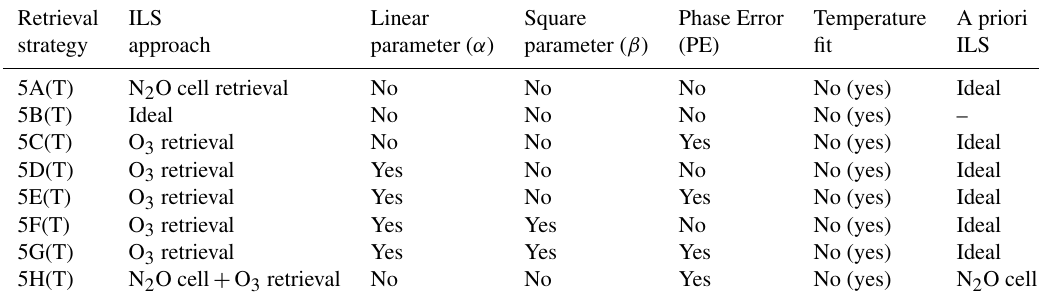
Table 1. Description of the FTIR O 3 retrieval strategies with different ILS characterizations and with and without a simultaneous atmospheric temperature profile retrieval ( the set-ups fitting the temperature profile are given in brackets). The 5A, 5AT, 5B, and 5BT configurations consider the cell-derived and the ideal ILS, respectively. The remaining set-ups fit some of the ILS parameters in the O 3 retrieval procedure. Note that the level of refinement of the ILS retrieval increases from set-up 5C to set-up 5H. Retrieval ILS Linear Square Phase Error Temperature A priori strategy approach